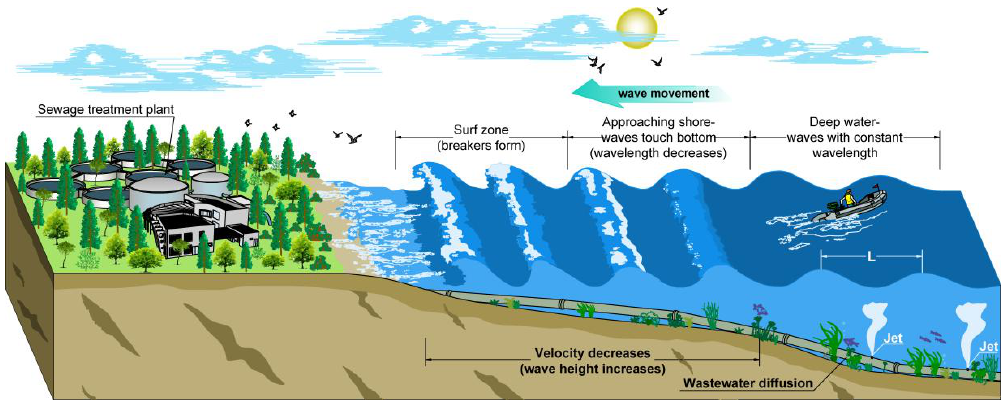
Figure 1. Typical release of jets in wave environment. The discharge region is located offshore of the surf zone.